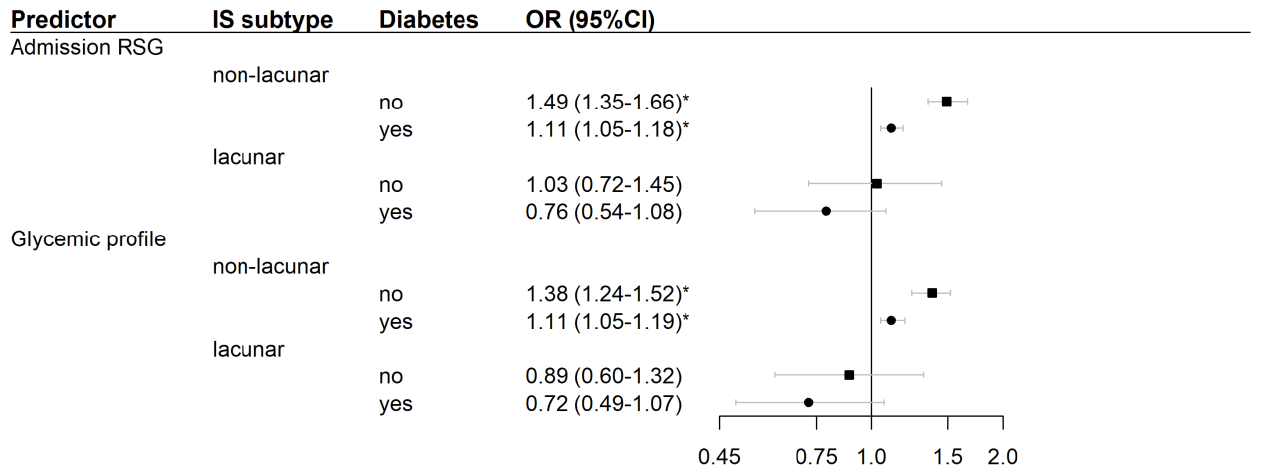
Figure 1. Association of continuous glucose predictors with poor outcome of ischemic stroke (IS) in patients without hypoglycemia. Odds ratios (OR) are for a unit increase in random serum glucose (RSG) on admission and early glucose profile (defined as the difference of fasting serum glucose measured the morning after admission and admission RSG). The logistic model was adjusted for age, sex, prestroke disability, admission National Institutes of Health Stroke Scale score, and reperfusion therapy. Patients were stratified by IS subtype, and diabetes status because the logistic model included significant interactions of RSG and early glycemic profile with both these characteristics. Poor outcome was defined as early neurological deterioration, severe stroke at Stroke Unit discharge, or death at 30 days after stroke onset. Analysis included only patients with RSG and FSG ≥ 3.9 mmol/L. Data are for 2088 non-lacunar patients without diabetes (400 cases), 862 non-lacunar patients with diabetes (205 cases), 508 lacunar patients without diabetes (23 cases), and 241 lacunar patients with diabetes (3 cases). Significant ORs ( p -value < 0.05) are marked with *.